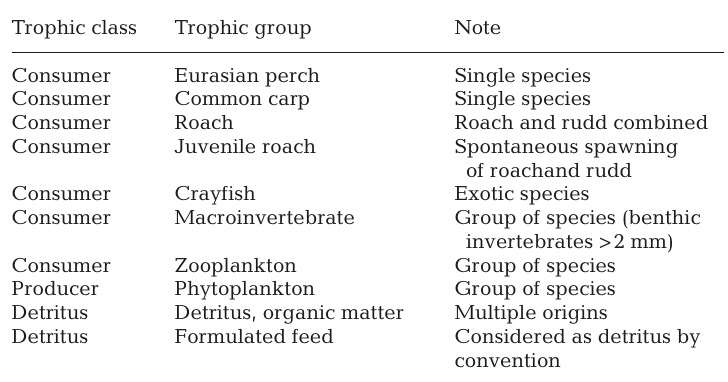
Table 2. Trophic groups considered in the food web model of